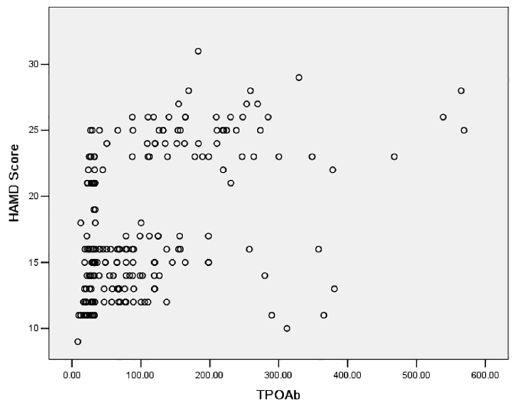
Fig 1. Scatter plot of correlation between HAMD score and